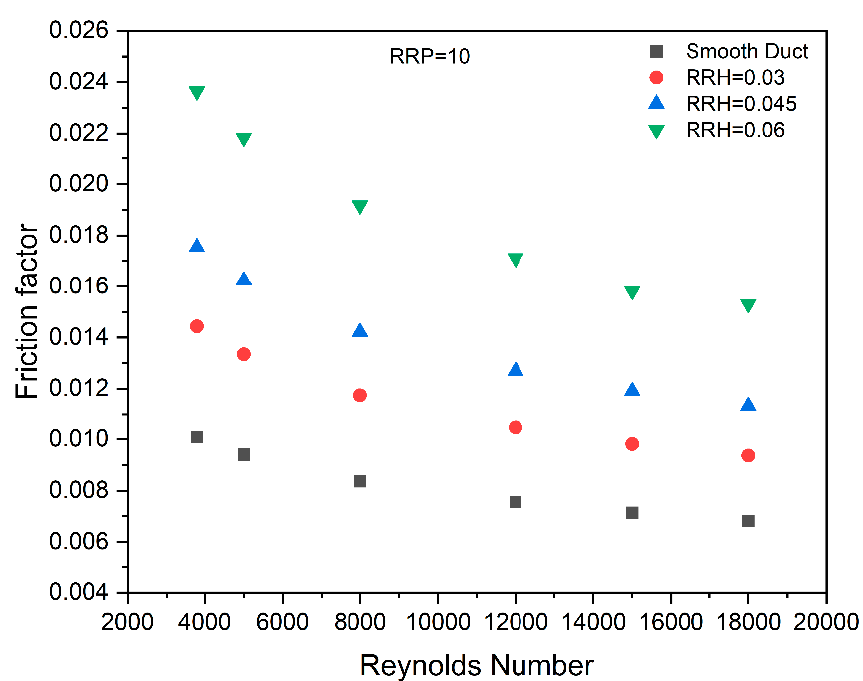
Figure 15. Nu r versus RRH .